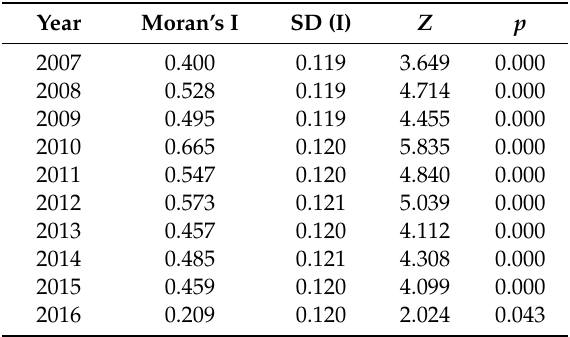
Table 3. Moran’s I index of environmental protection expenditure e ffi